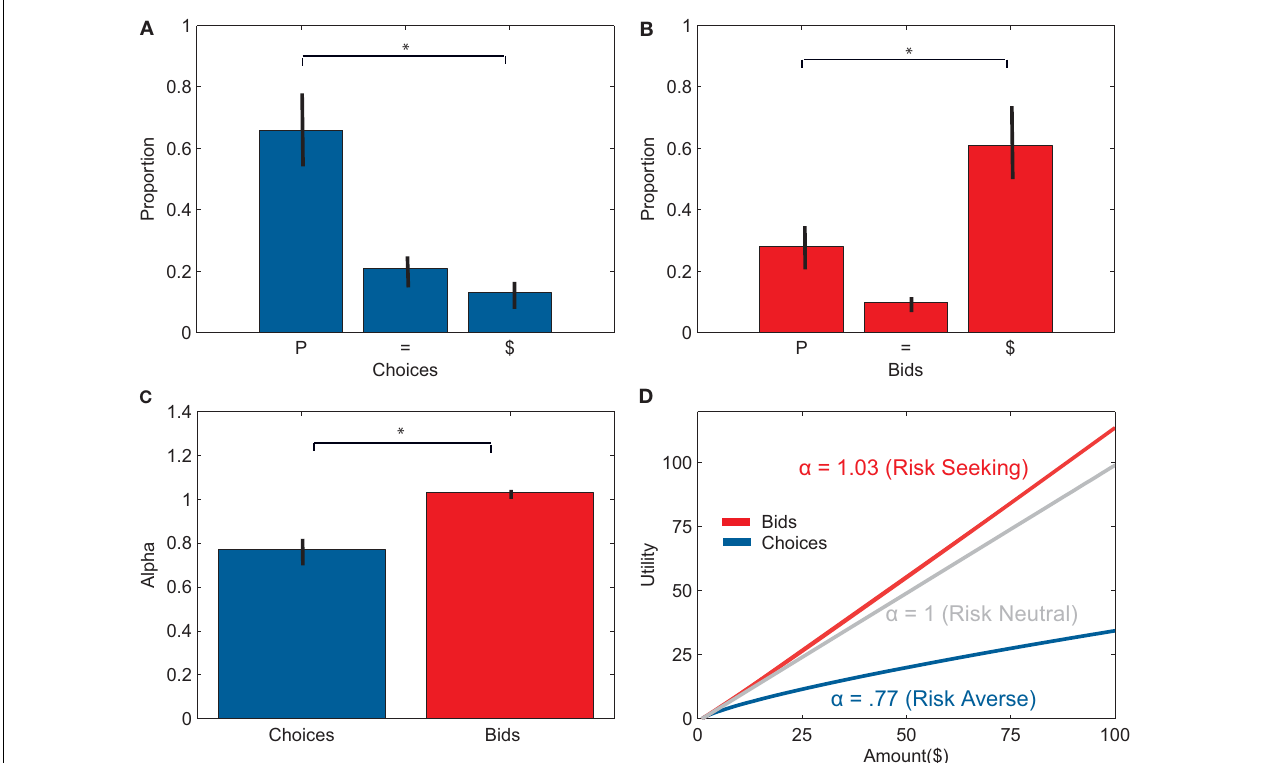
$-bets than on the P-bets . (C) Average alpha values for choice trials and bid trials. Alphas were significantly higher for bidding than for choice. (D) The average expected utility function for bids and choices given the inferred alphas. Subjects were risk-averse during choices and slightly risk-seeking during